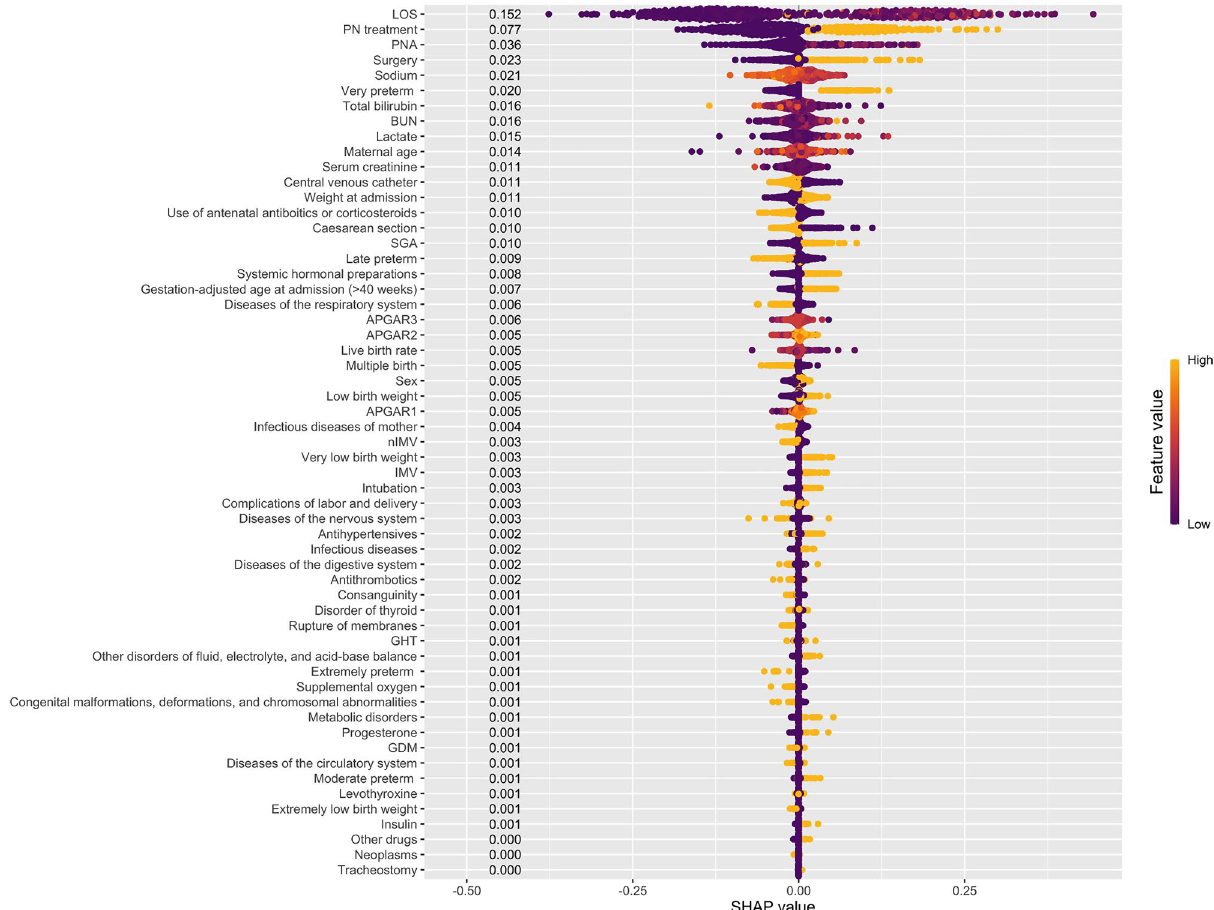
Figure 2. SHAP values for the presence of weight gain at discharge